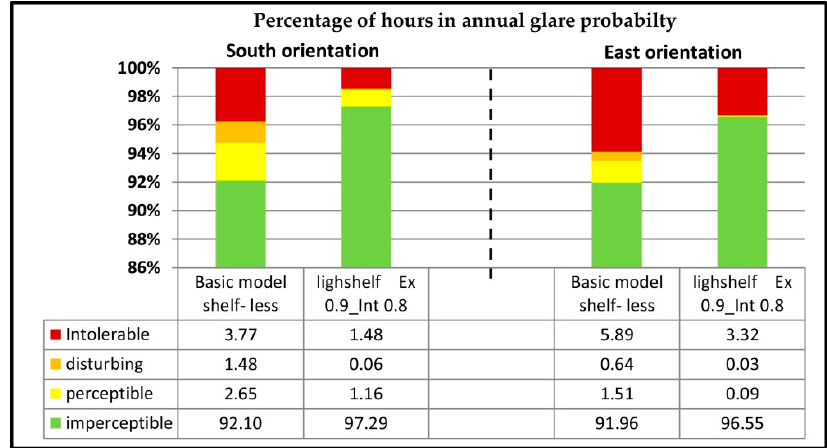
Figure 9. Results percentage of the annual visual comfort analysis with the DGP index, for the southern and eastern orientations, compared to the light shelf and the lack of it during annual hours.